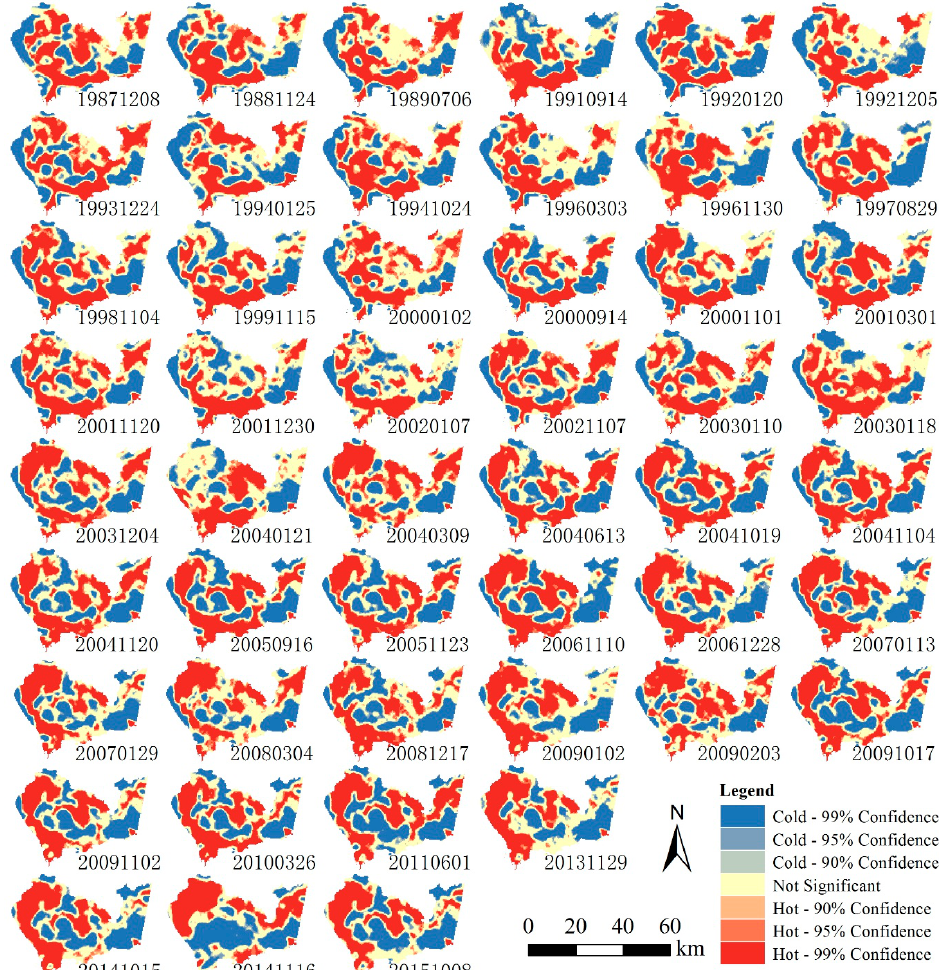
Figure 5. Changes in hot and cold spots of land surface temperature in the main city of Shenzhen.